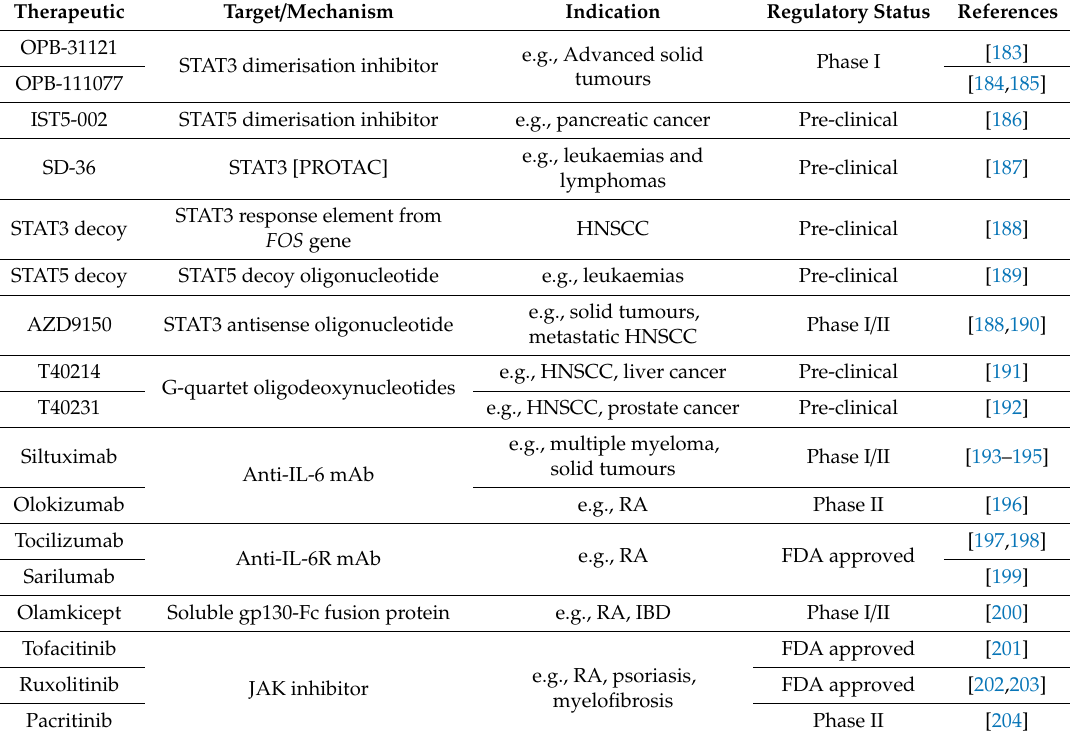
Table 1. Current therapeutic strategies to inhibit the JAK / STAT pathway. Details are discussed in the text. PROTAC, proteolysis targeting chimera; HNSCC, head and neck squamous cell carcinoma; mAb, monoclonal antibody; RA, rheumatoid arthritis, FDA, Food and Drug Administration; IBD, irritable bowel